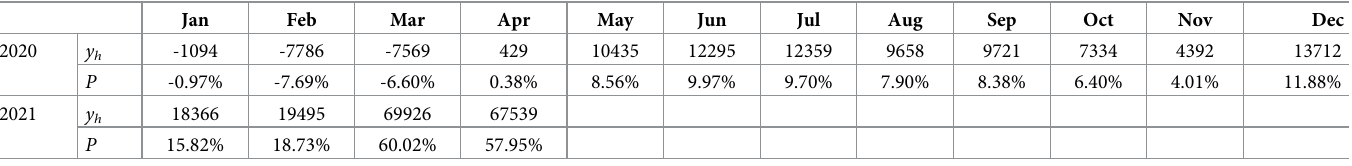
Table 5. Excess of deaths for the Brazilian dataset.